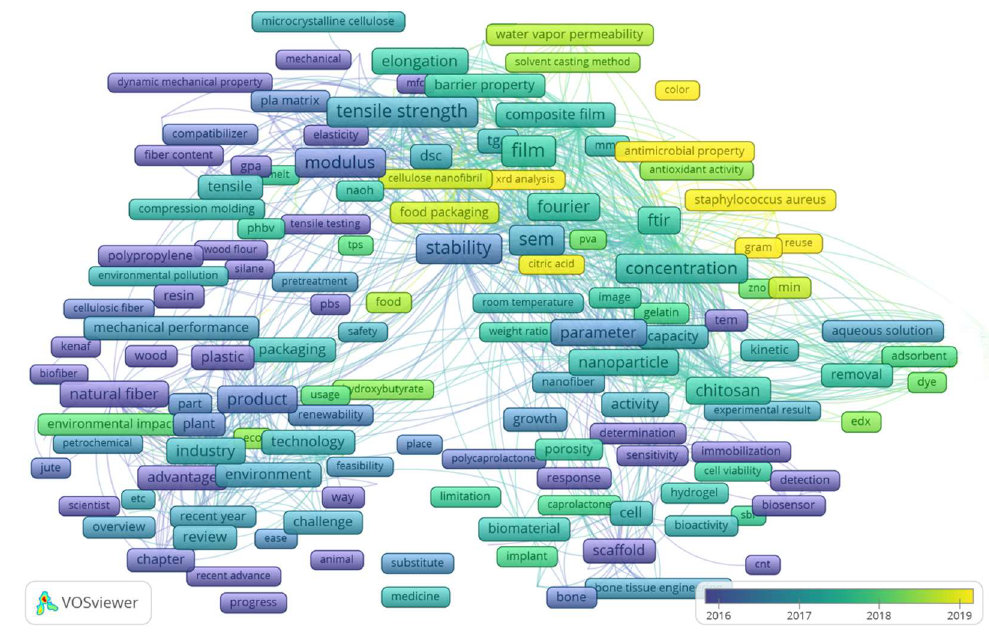
Figure 5. The overlay visualization of co-occurrence of keywords “biocomposite” and “biopolymer” based on the SCOPUS articles, which was created by the authors using VOSviewer (version 1.6.17).